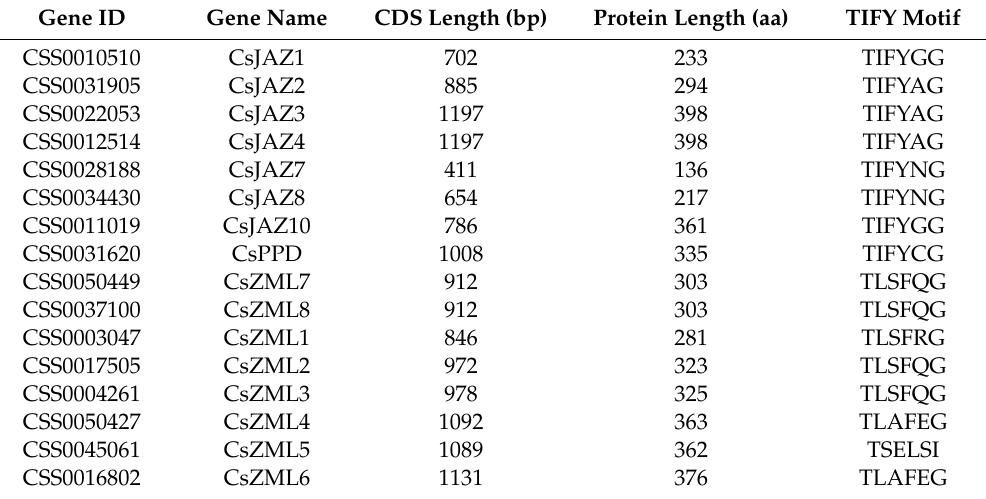
Table 1. Basic information of CsTIFY gene